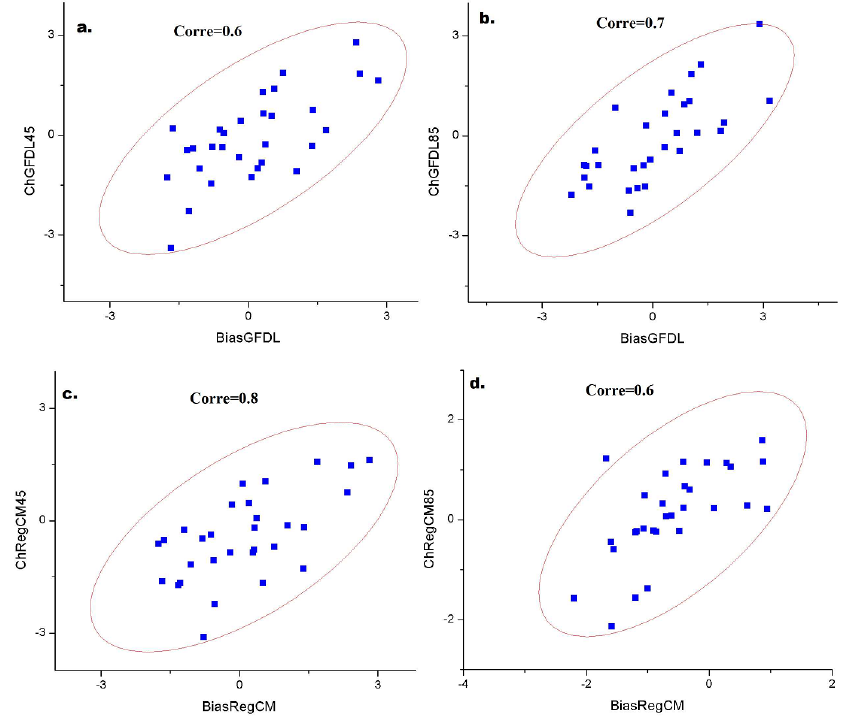
Figure 13. Effect of precipitation bias on the projected changes in SASM for GFDL − ESM2M ( a , b ) RegCM4 ( c , d ) under both scenarios. Ellipses indicates that the biases are significant at 95% confidence